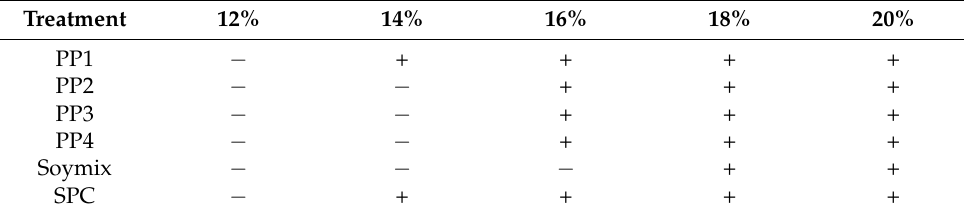
Table 6. Least gelation concentrations for raw mixes based on pea and soy protein. The symbol ‘+’ means gel was observed the given concentration and the symbol ‘ − ‘ means gel was not observed. Gluten not tested due to its